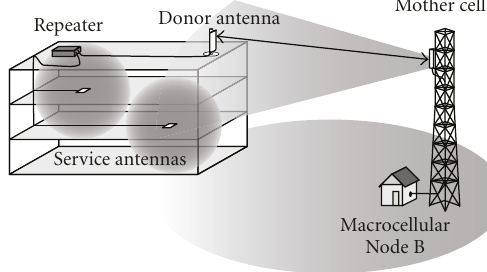
Figure 1: Dedicated indoor system using a dedicated indoor base station.